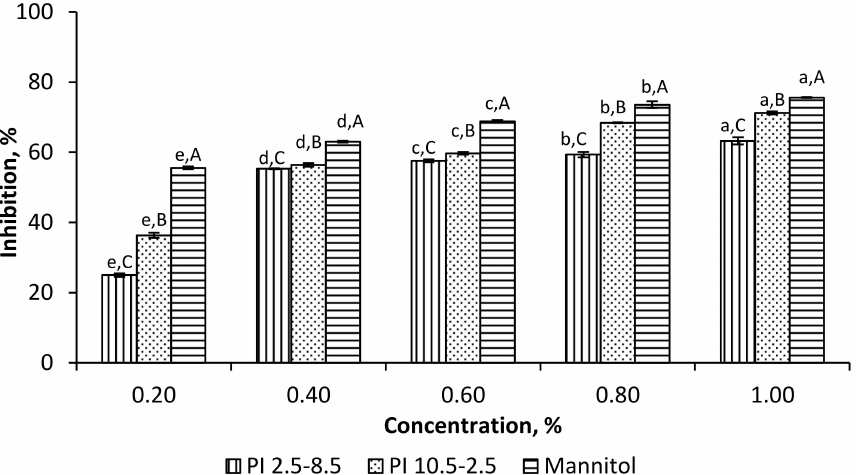
Figure 4. Hydroxyl radical scavenging activity of ethanol-treated rapeseed meal protein isolates, PI 2.5–8.5 and PI 10.5–2.5 . a–e Means of one sample with different concentrations without a common letter differ significantly ( p < 0.05). A–C Means of the samples with the same concentration without a common letter differ significantly ( p < 0.05).